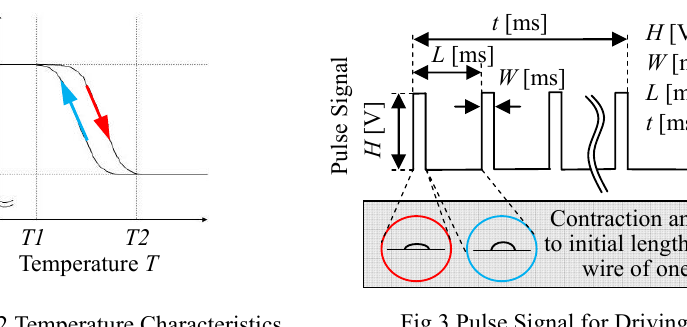
Fig.2 Temperature Characteristics Fig.3 Pulse Signal for Driving